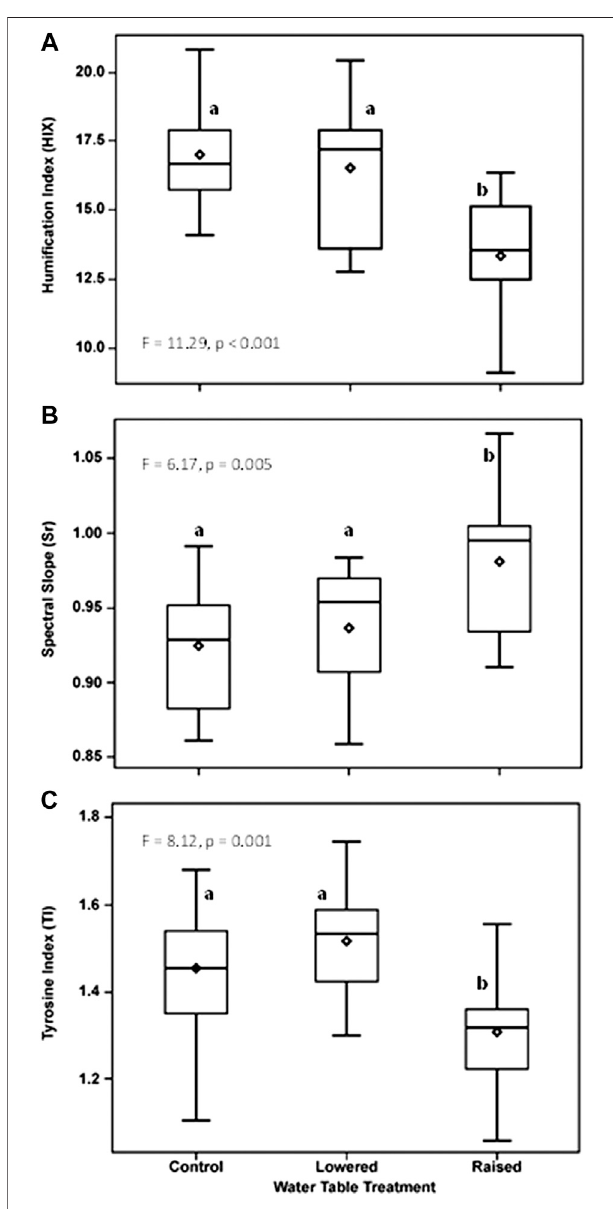
FIGURE5 | Water table treatment differences in an index ofhumi fi cation (HIX, (A) , an index of photodegradation or an inverse index of bioavailability (Sr, (B) , and an index of free or bound protein (TI, (C) of water taken 10 cm below the surface of the water during fl ooding throughout the 2018 growing season. Depicted are seasonal means by water table treatment plot. Letters indicate signi fi cant differences in post-hoc comparisons of means.